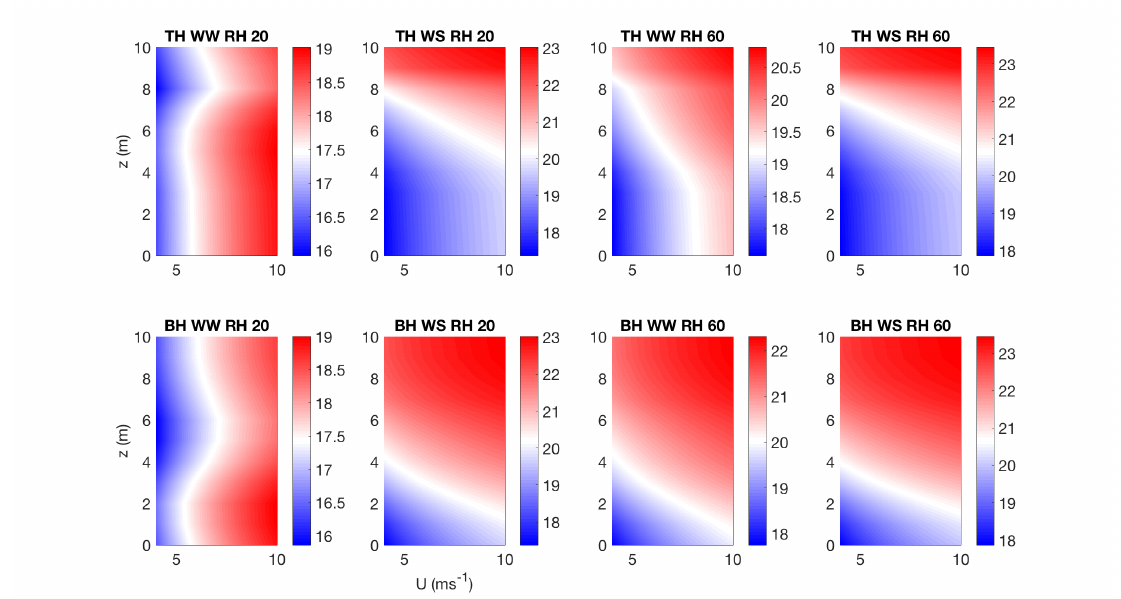
Figure 10. Variation of leaf level canopy temperature with height and wind speed for different water supply and demand conditions for low light level—well watered, high demand (WW RH20); water stressed, high demand (WS RH20); well watered low demand (WW RH60) and water stressed low demand (WS RH60). The top row shows these conditions for the top heavy (TH) scenario and the bottom row for the bottom heavy (BH) scenario. The color bars indicate leaf level canopy temperature in ◦ C.